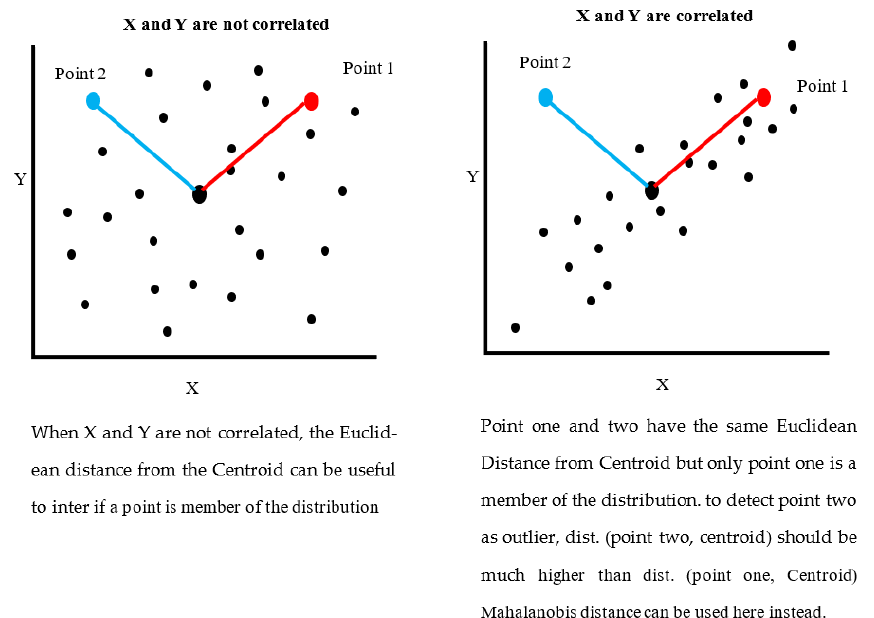
Figure 7. The difference between Euclidean and Mahalanobis Distance and how the Mahalanobis Distance is calculated using the variances of data points in RGB space.